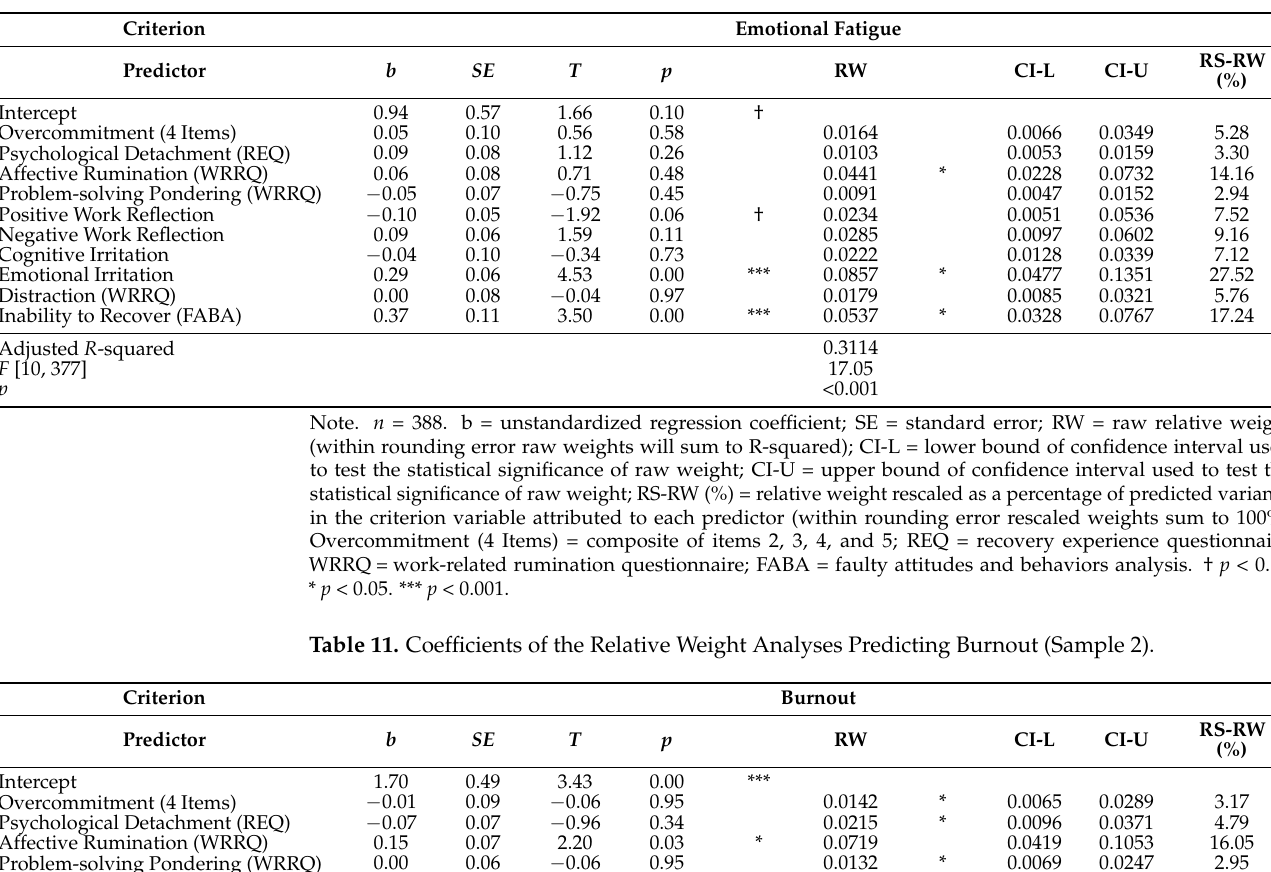
Table 10. Coefficients of the Relative Weight Analyses Predicting Emotional Fatigue (Sample 2).